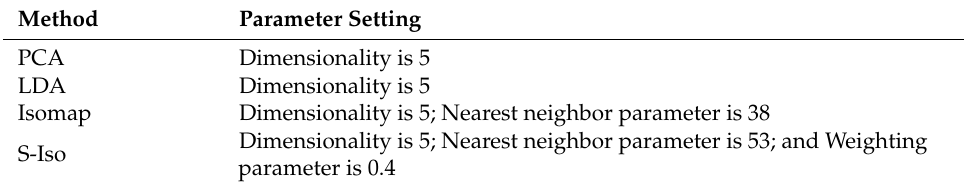
Table 5. Performance comparison between four